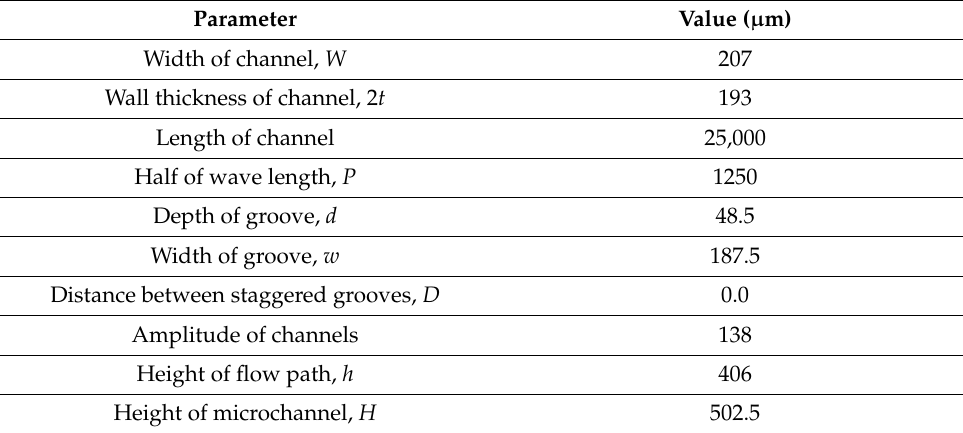
Table 1. Dimensions of the reference wavy channel with